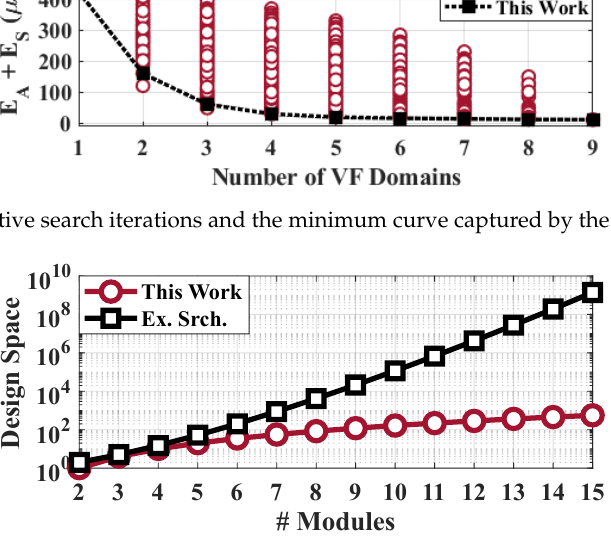
Figure 5. Design space of Exhaustive Search and the Proposed Framework with respect to # of